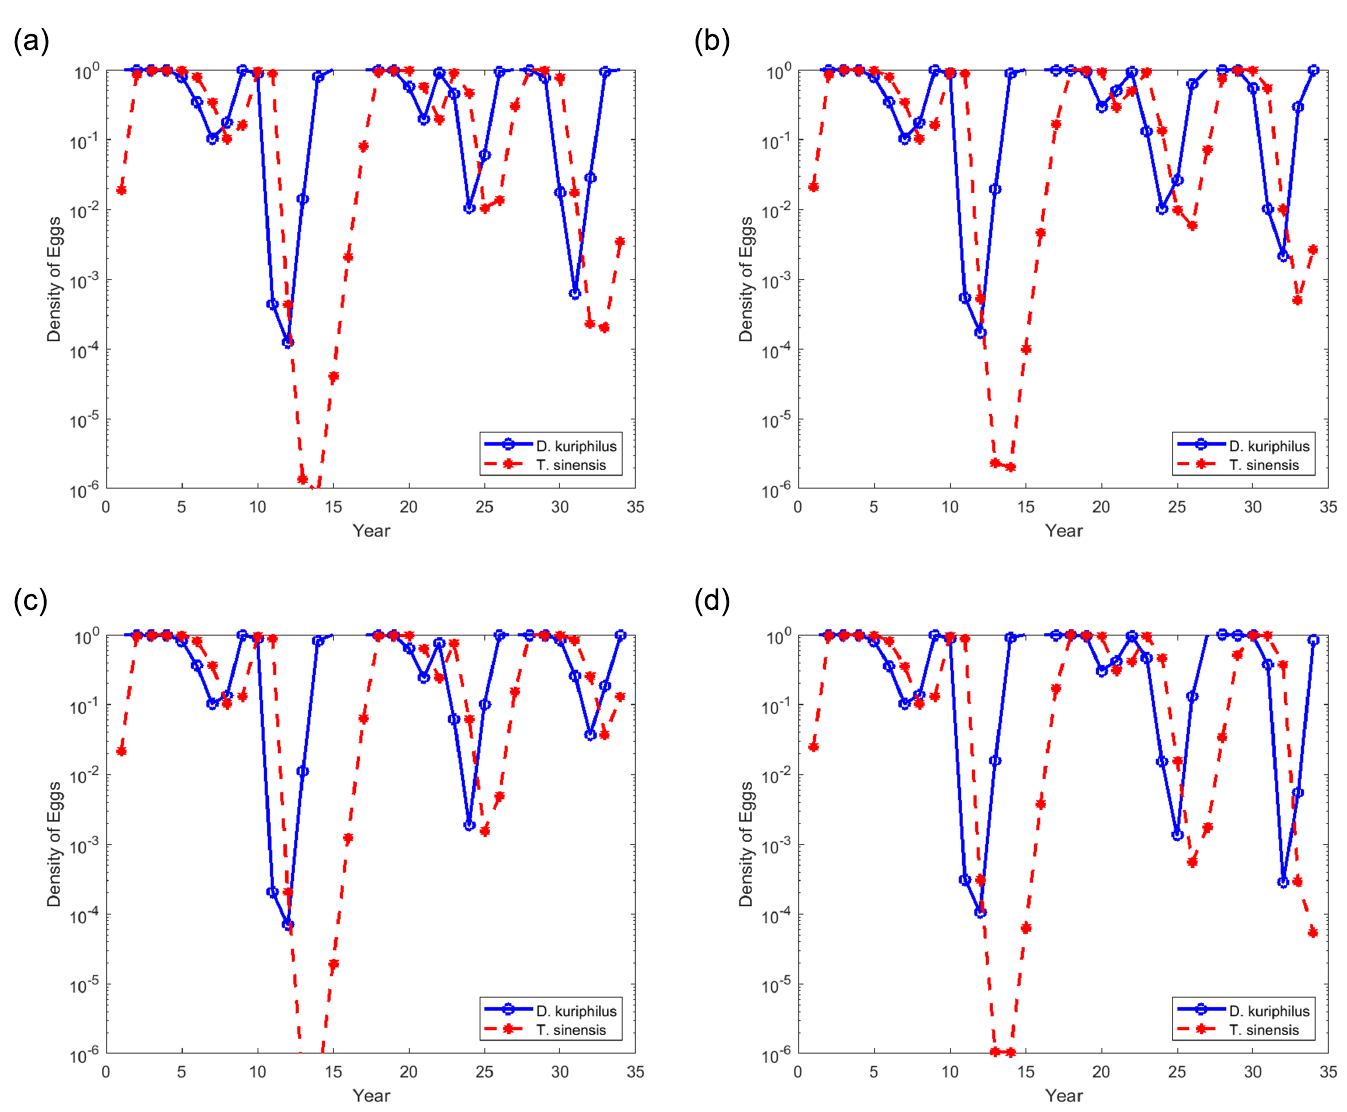
Fig 6. Egg density of D. kuriphilus ( v n ) and T. sinensis ( q n ) in a given place of the forest over the